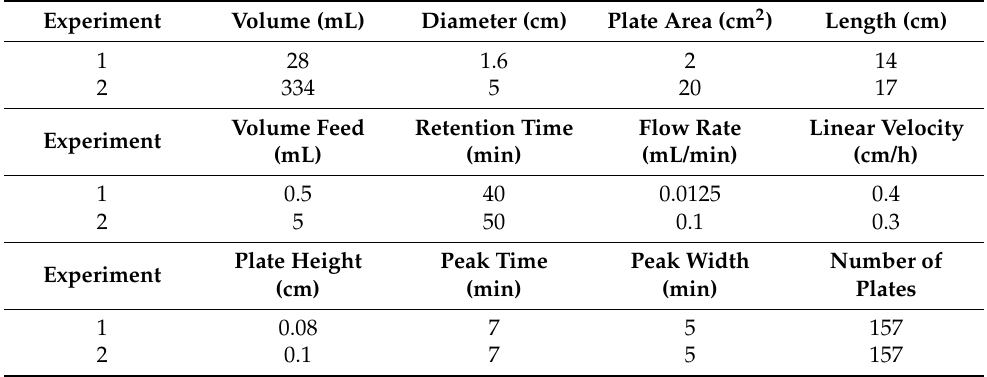
Table 1. Experimental data of (HIC-1) for A and C Van Deemter coefficients